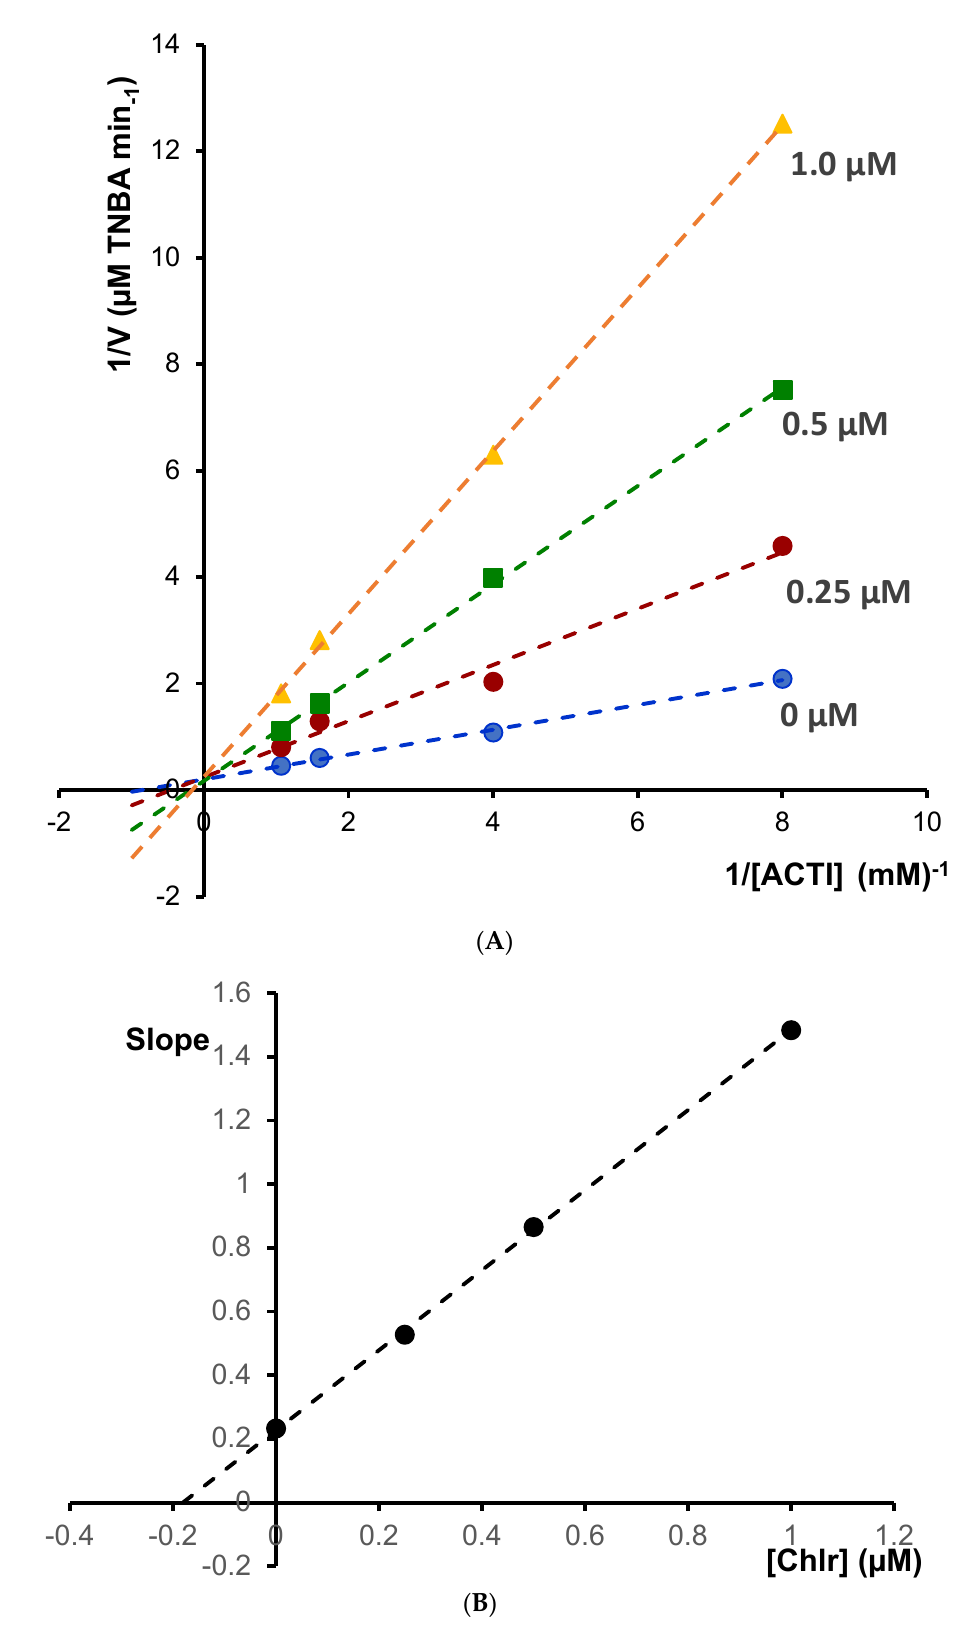
Figure 5. ( A ) Lineweaver–Bulk plot of acetylcholinesterase activity over a range of substrate concen-